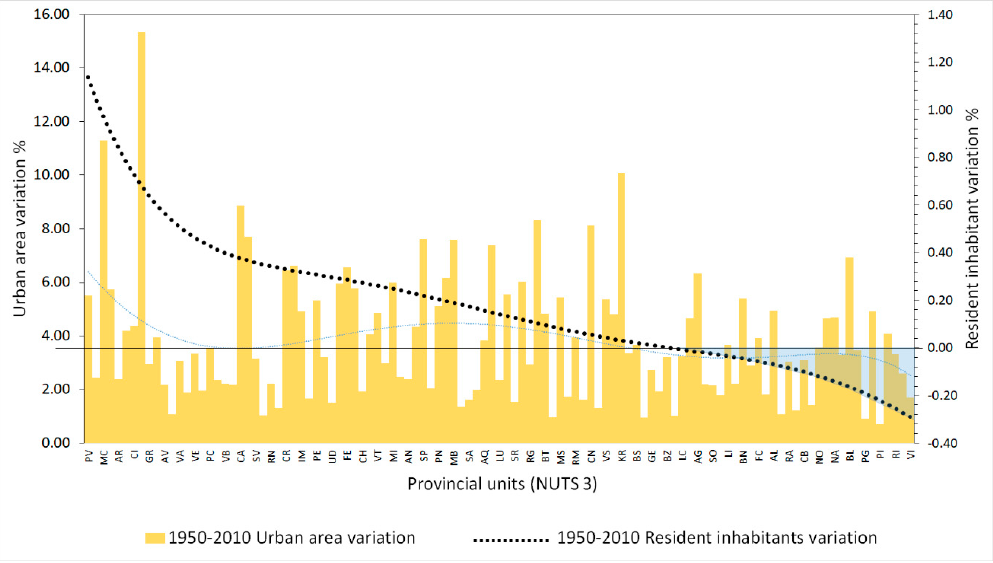
Figure 6. Bar chart showing the variation in urbanized areas compared to the population variation curve in the 110 provincial areas NUTS 3.